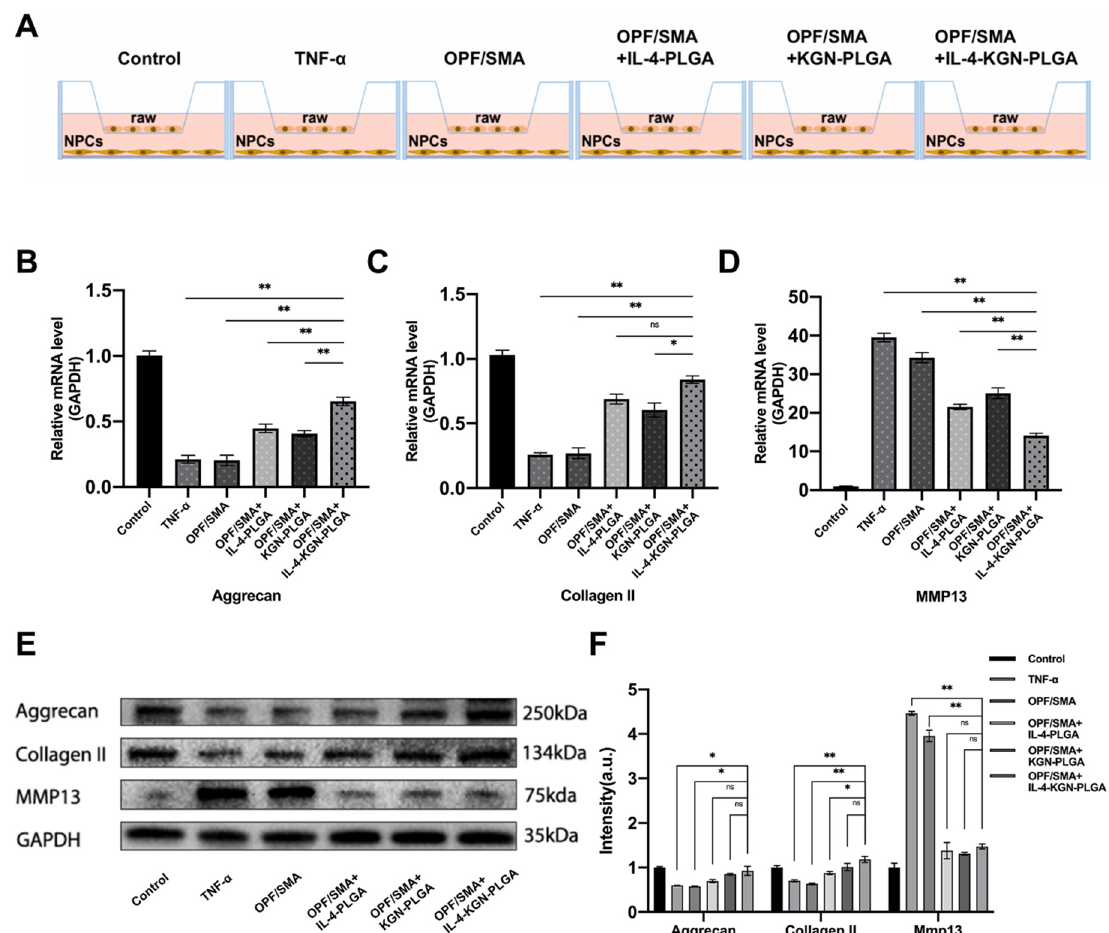
Figure 5. ( A ) The upper chamber of transwell is 1 × 10 5 raw264.7, and the lower layer is 1 × 10 5 nucleus pulposus cells. After the intervention of TNF- α 50 ng/mL for 6 h, the conditional medium replaced with hydrogel was intervened for 24 h. ( B – D ) Quantitative real-time reverse transcriptase- polymerase chain reaction (qRT-PCR). ( E , F ) Western blot detection. Grayscale analysis of protein bands. Statistical significance was calculated by two-way ANOVA. * p < 0.05, ** p < 0.01, ns > 0.05.